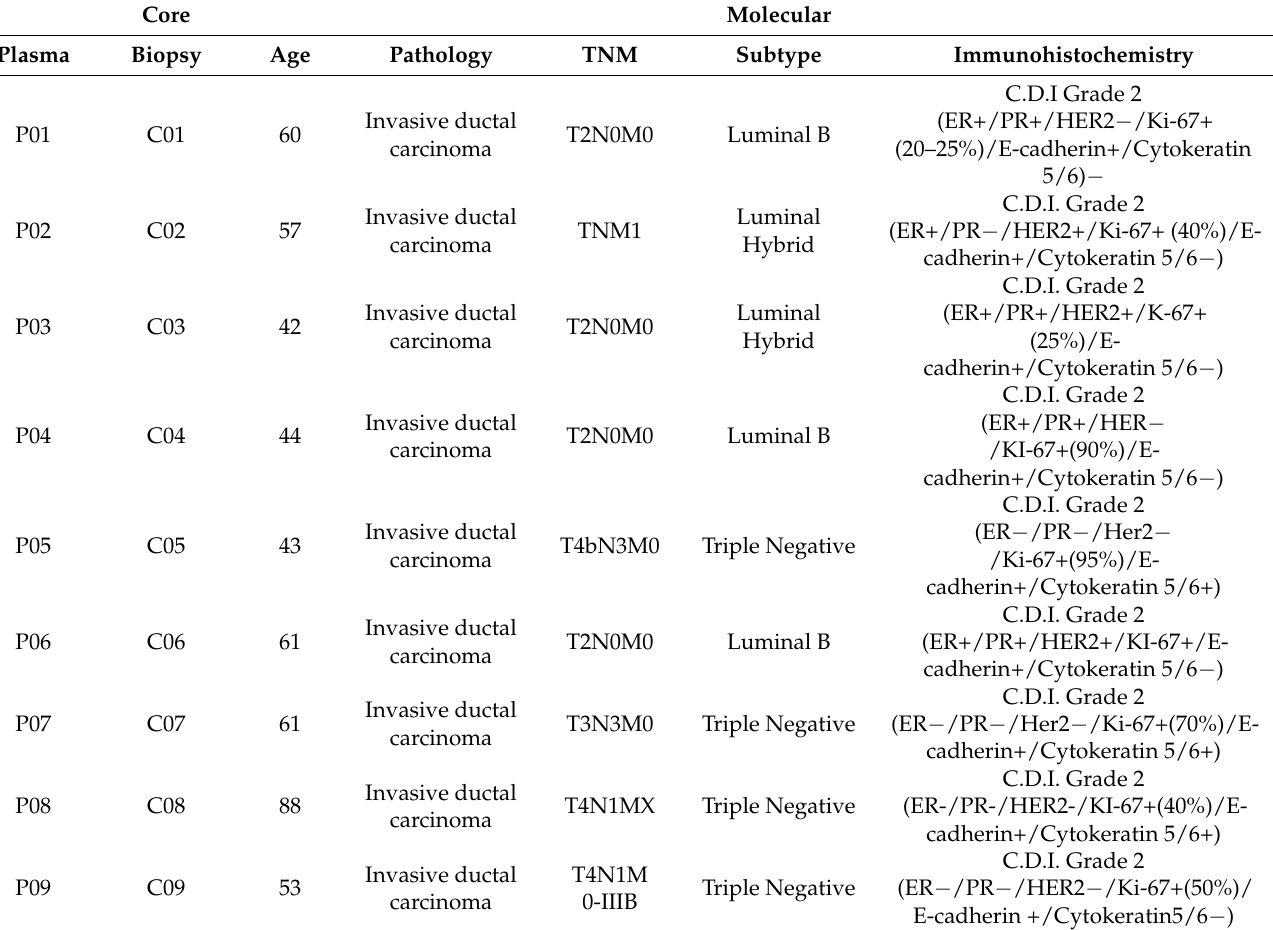
Table 1. Histopathological features of BC samples in newly diagnosed